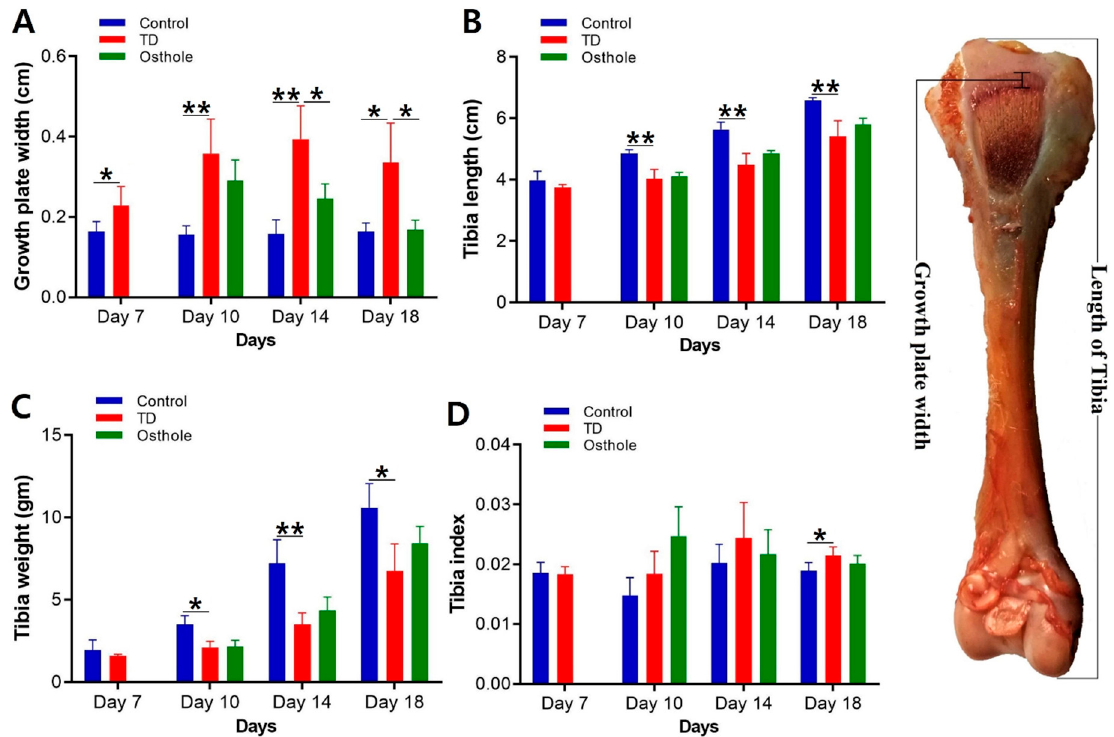
Figure 6. Tibia parameter analysis of the control, thiram, and osthole groups on various days, * p < 0.05: ( A ) growth plate width, ( B ) tibia length, ( C ) tibia weight, and ( D ) tibia index.